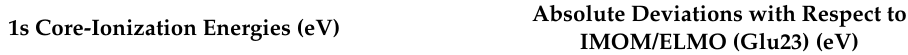
Table 5. 1s core-ionization energies obtained for the C α and the side-chain non-hydrogen atoms of residue Glu23 in the protein crambin, as resulting from IMOM/ELMO calculations on the full protein (Glu23 as QM region), and from IMOM/ELMO and fully IMOM computations on the isolated glutamate residue properly capped with the N-methyl amino and acetyl terminal groups. All the calculations were carried out at PBE0/6-311G(d,p) level. The deviations from the 1s core ionization energies obtained at IMOM/ELMO level on the isolated residue are also